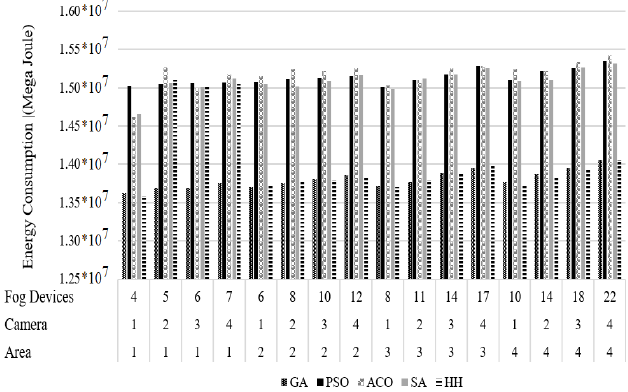
Figure 5. Energy consumption of GA, PSO, ACO, SA, and HHS.